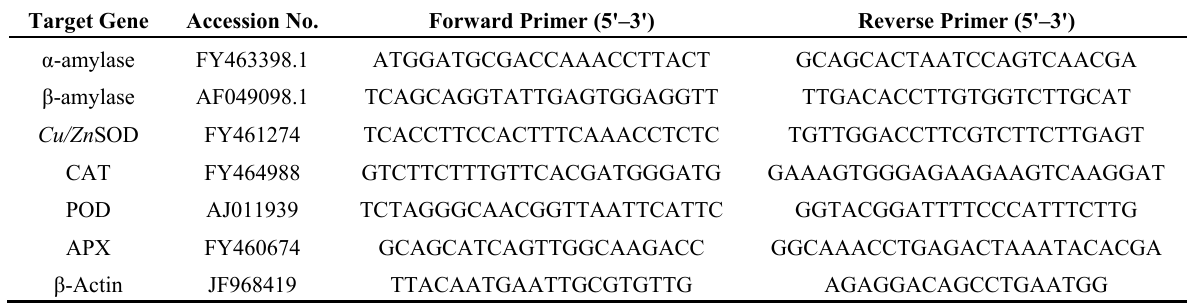
Table 6. Primer sequences and their corresponding GeneBank accession numbers of the analyzed